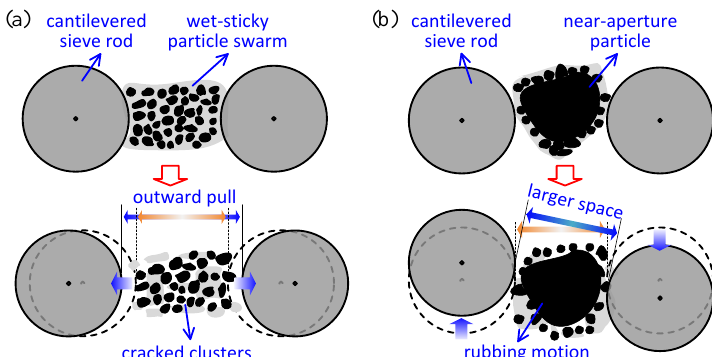
Figure 4. Anti-plugging mechanism of cantilevered vibrating sieve (CVS) induced by ( a ) transverse shift and ( b ) longitudinal shift of cantilevered sieve rod.